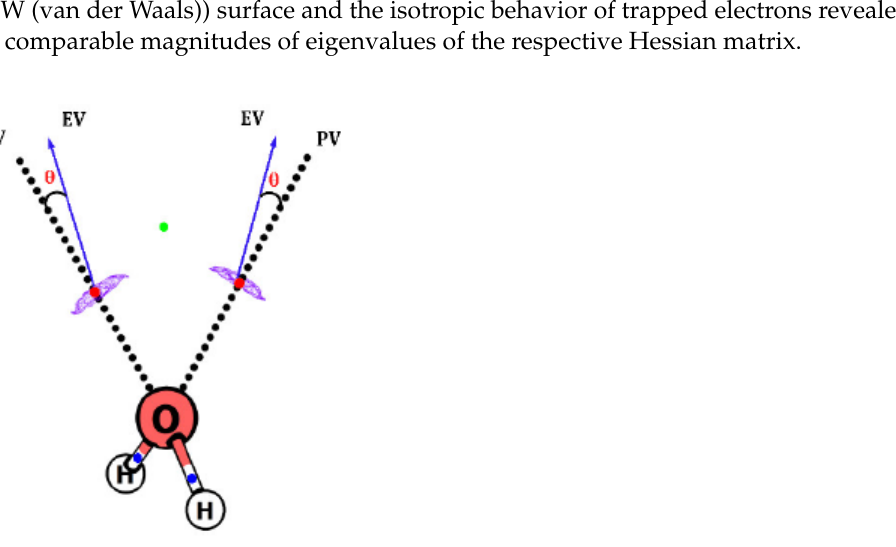
Figure 5. Direction of the eigenvector, EV, corresponding to the largest eigenvalue (blue arrow) and position vector, PV (dotted line), for H 2 O at MP2/6-311++G(d, p) level theory. θ is the angle between EV and PV is denoted as θ . See text for details.